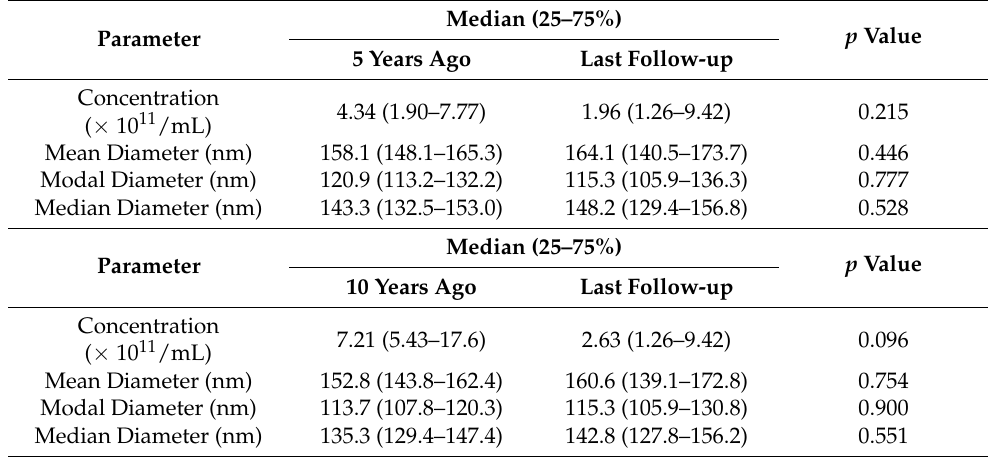
Table 5. uEV characteristics of chronological samples in 5- ( n = 18) and 10-year periods ( n = 14).